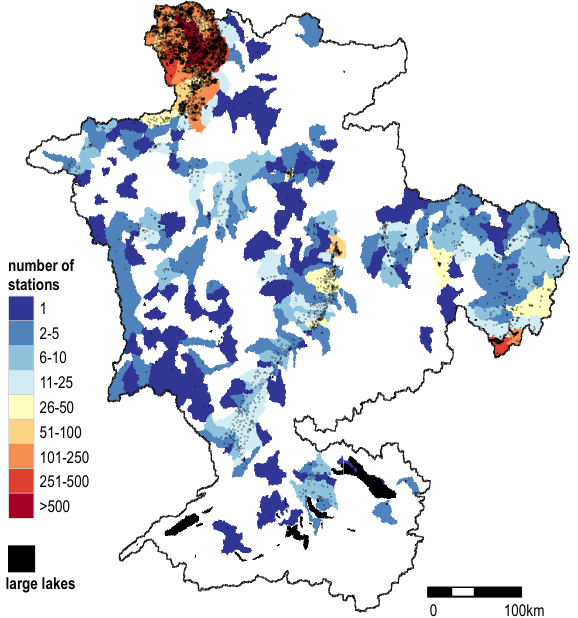
Fig. 8. The sub-basin averages of absolute mean biases, based on the reference scenario A01.0